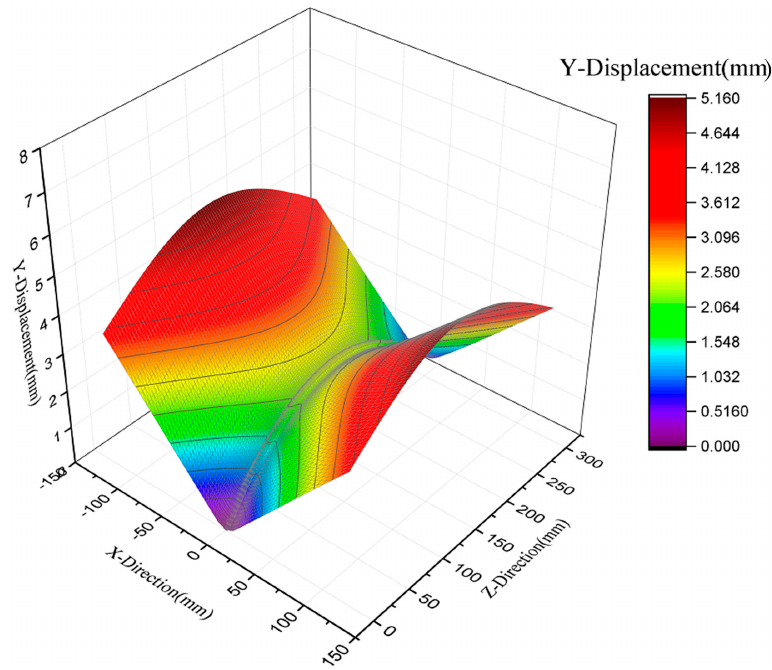
Figure 11. Three-dimensional (3D) image of welding deformation without jigs.